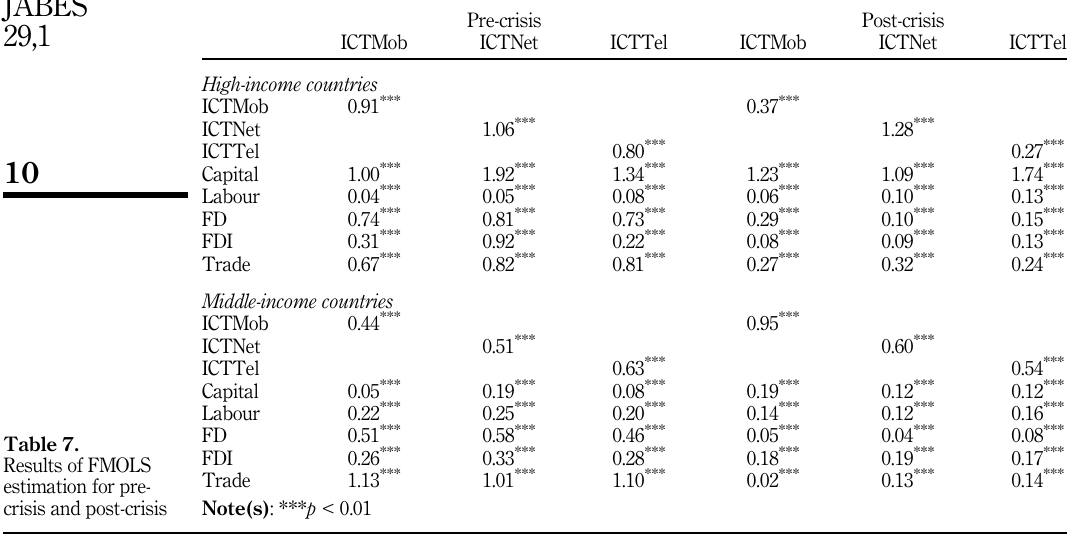
Table 7. Results of FMOLS estimation for pre- crisis and